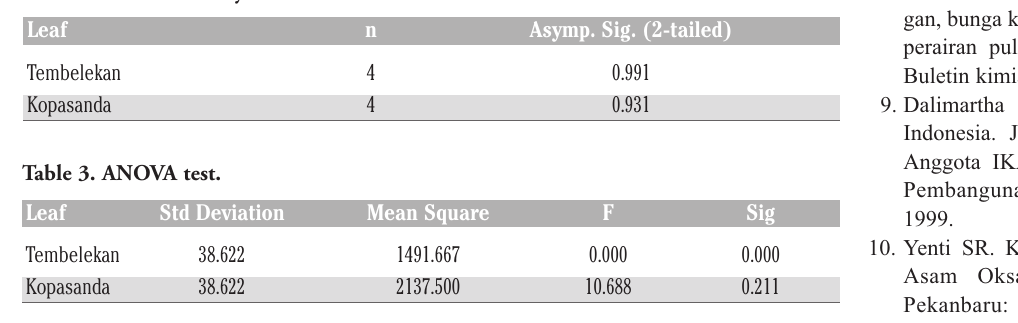
Table 2. Data normality test.